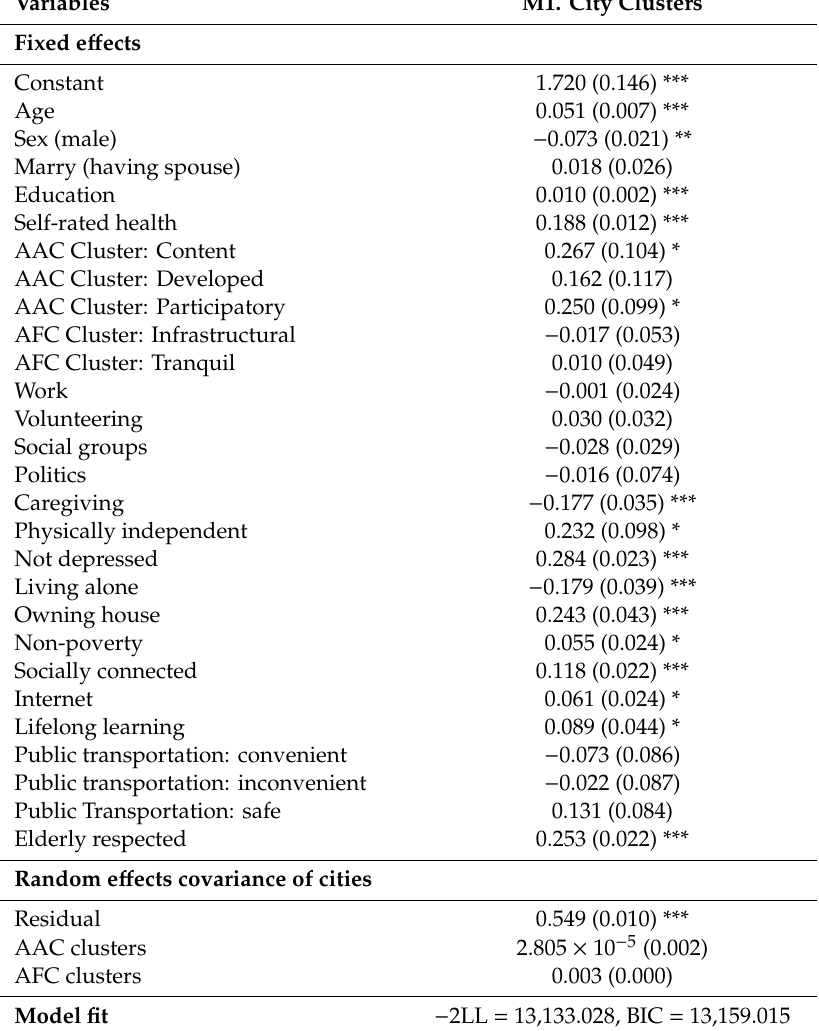
Table 4. Life satisfaction with city clusters and individual factors of older adults (age 55 +